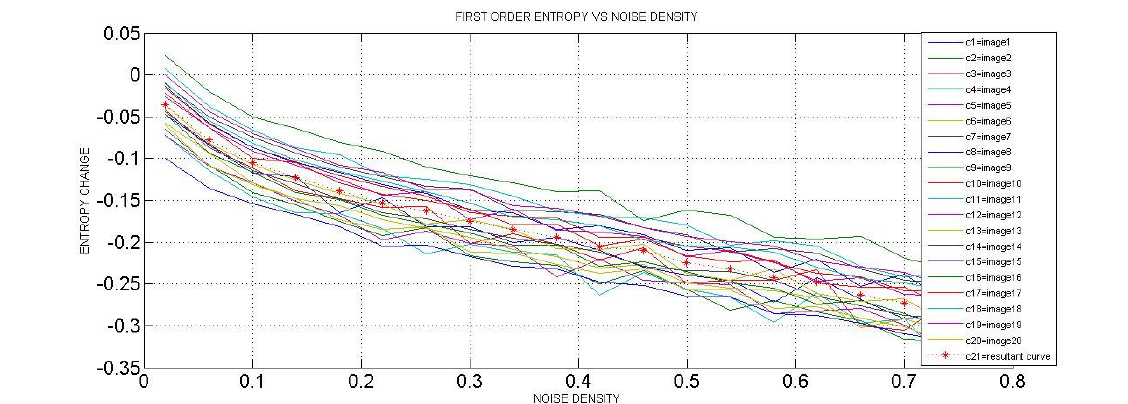
Figure 2. First order Entropy vs Noise Density